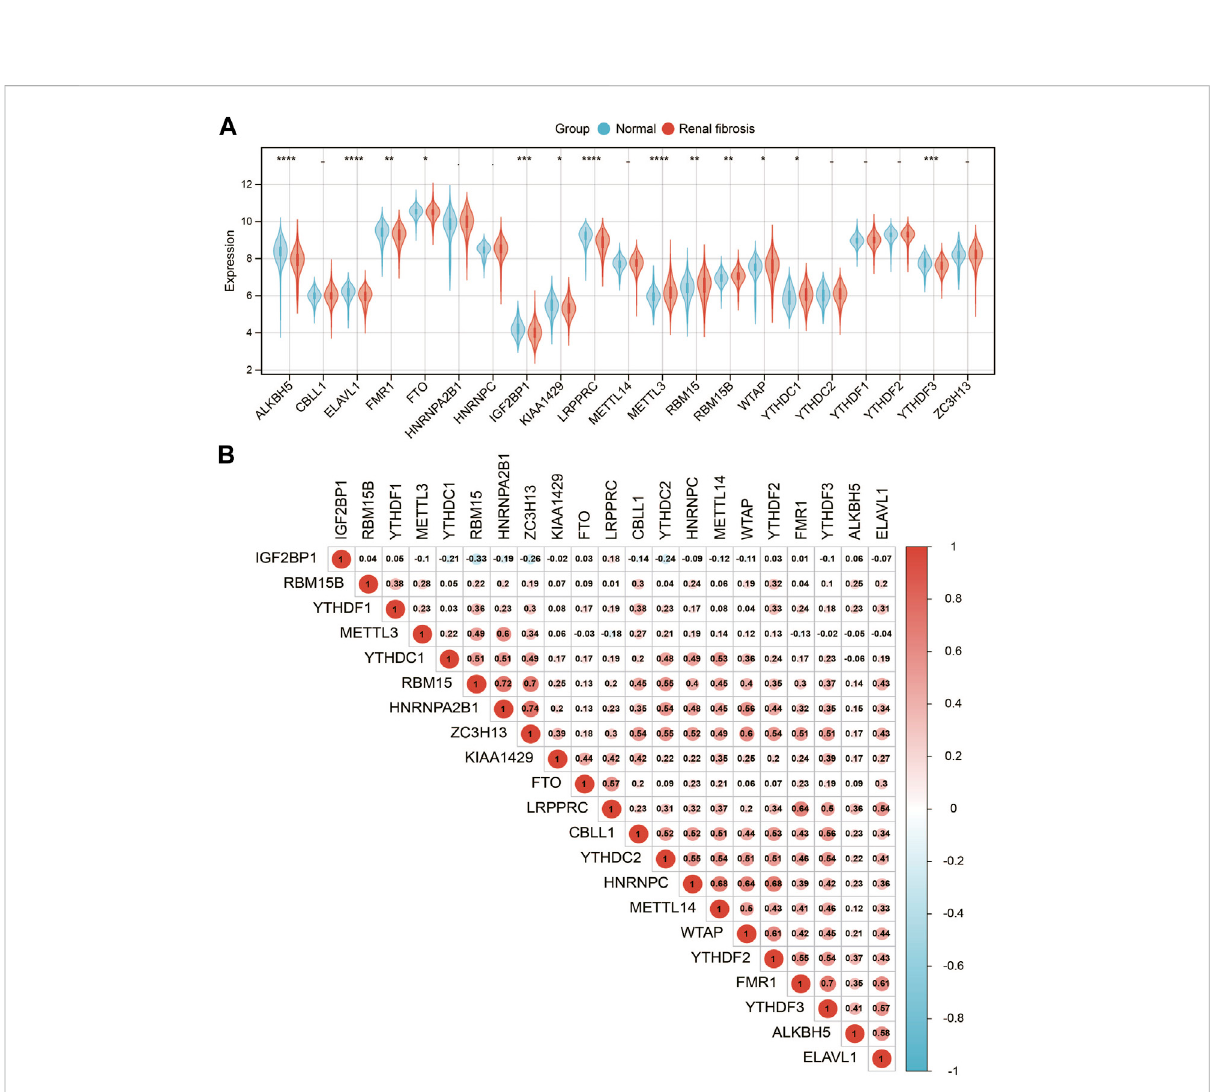
FIGURE 2 Expression landscape of m6A RNA methylation regulators in renal fi brosis. (A) Boxplot of the transcriptome expressions of 21 m6A regulators between healthy and renal fi brosis samples. (B) Heatmap of expression level correlations of 21 m6A regulators. * means p less than 0.05; ** means p less than 0.01, *** means p less than